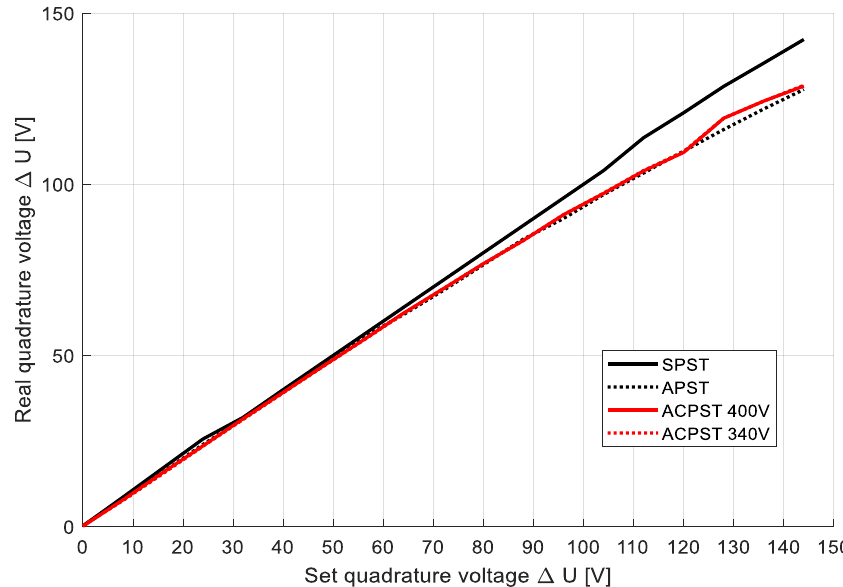
Figure 16. Real quadrature voltage versus set quadrature voltage for all PSTs.